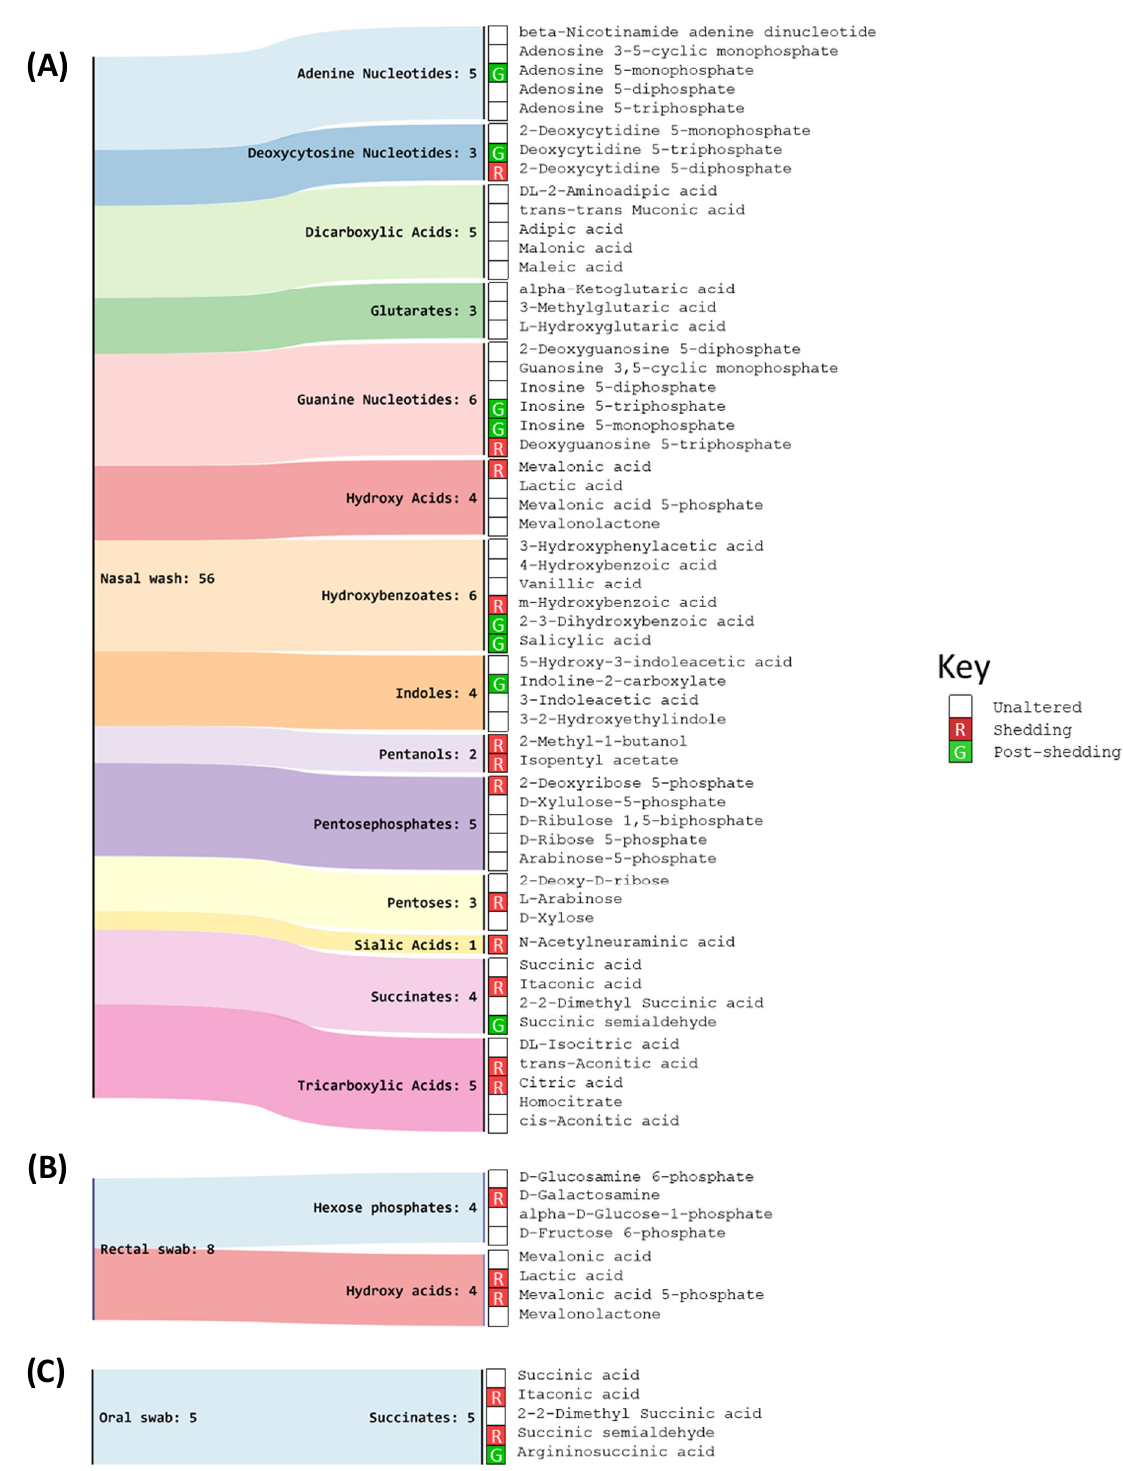
Figure 3. Identified metabolite clusters and the associated significant metabolites during viral shedding (green) and post-shedding (red) based on the acquired targeted central carbon metabolism metabolite dataset using the ChemRICH analysis tool. ( A ) nasal washes, ( B ) oral swabs, and ( C ) rectal swab. Altered significant metabolites (FC ≥ 1.5 or FC ≤ 0.66; p -value ≤ 0.05) identified in each cluster are illustrated in the heatmaps. The significant metabolites during viral shedding event are represented in red and those during post-shedding are represented in green in the heatmaps. The unaltered metabolites are represented in white.